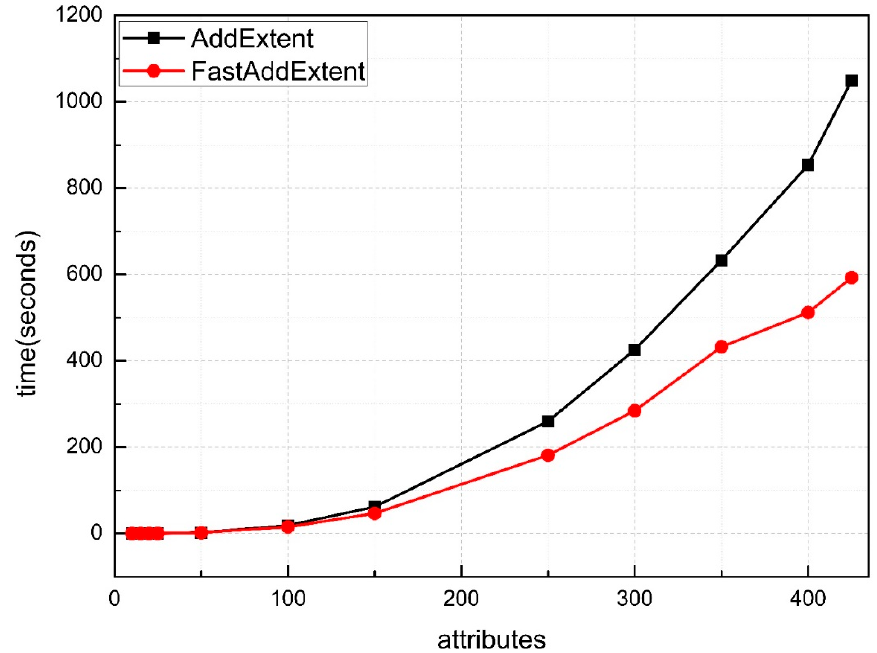
Figure 6. Results for random datasets with high density.